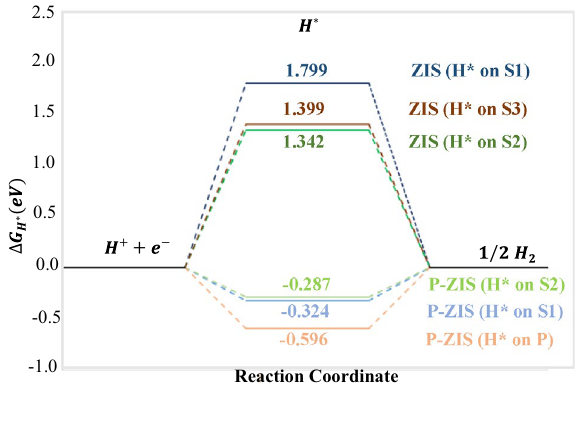
Figure 7. Free energy diagram for hydrogen evolution for each site on ZIS and